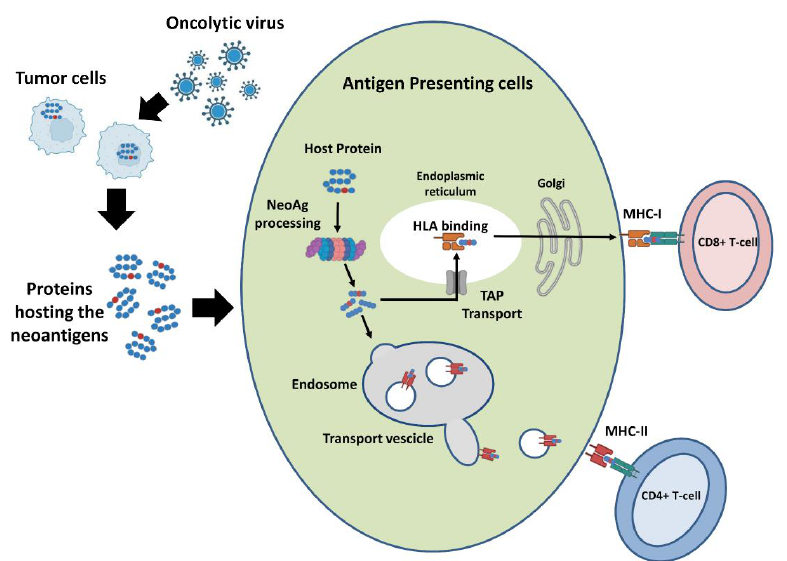
Figure 5. Pathway of TNAs presentation. Tumor cells encode a variable number of neopeptides with several abundance levels. The two major classes of proteins specialized for antigen presentation are the MHC class I and class II molecules, which present antigenic peptides to CD8+ T-cells and CD4+ T-cells, respectively. Only a small part of the expressed neopeptides is bound to MHCs and a lower fraction of these is recognized by T-cells.